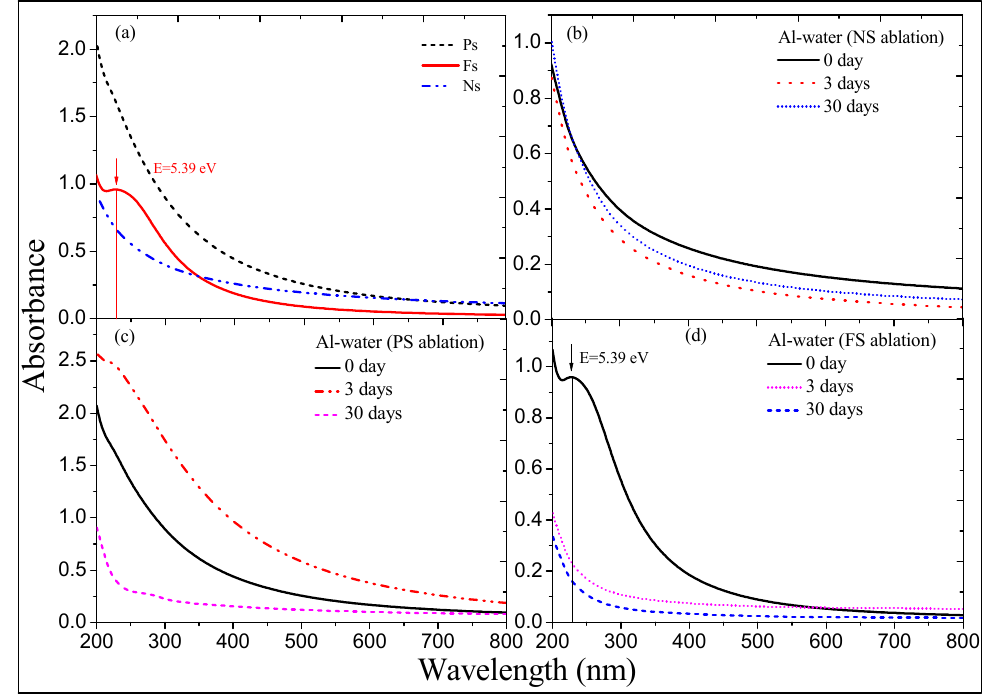
Figure 1. Absorption spectra of Al nanoparticles (NPs) colloidal solutions. ( a ) Absorption spectra measured immediately after ablation using different pulse durations (Ns: 5 ns, 1064 nm, 10 Hz, 48 mJ;